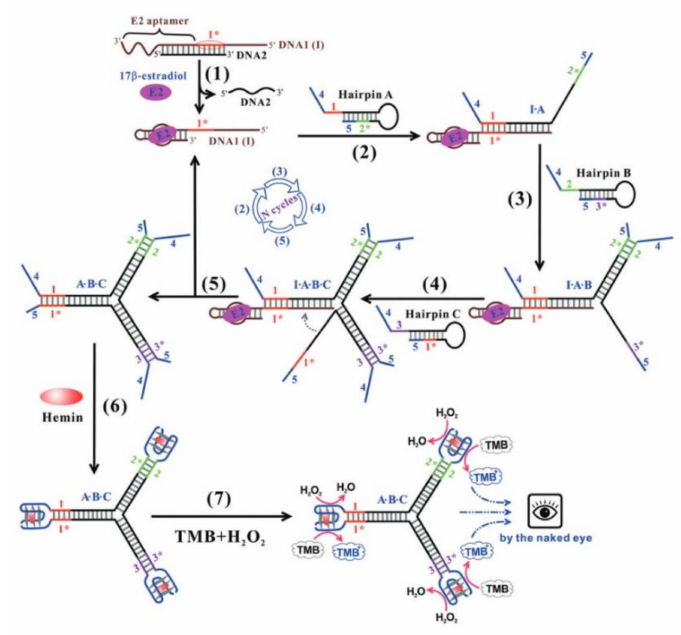
Figure 9. Scheme of diagnostic platform for detecting 17 β -estradiol [80]. Reproduced with permission from Royal Society of Chemistry (Great Britain), © The Royal Society of Chemistry